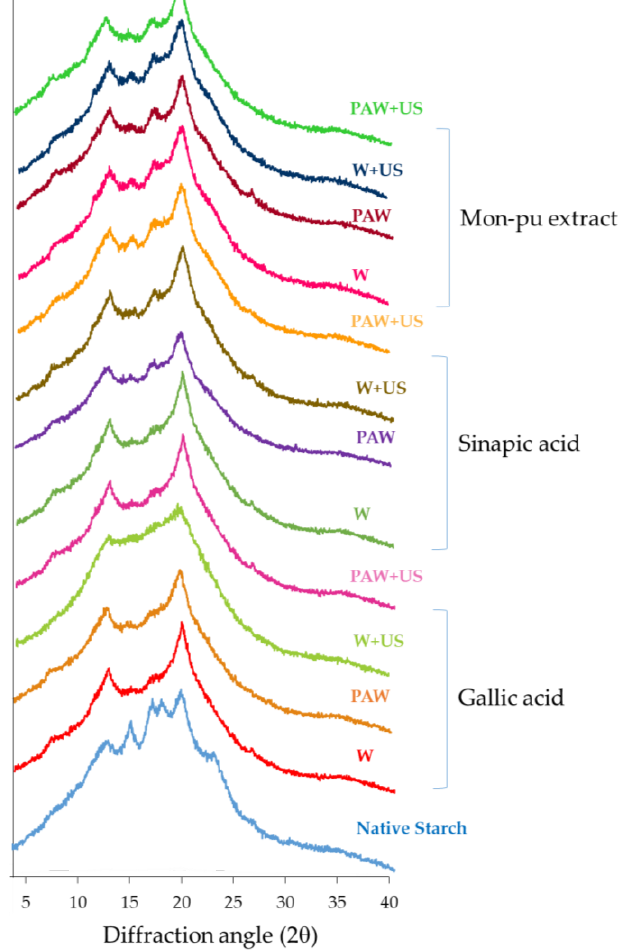
Figure 4. X-ray diffraction spectra of rice starch – phenolic complexes. Different phenolic compounds— gallic acid, sinapic acid, and crude Mon-pu ( Glochidion wallichianum Muell Arg) extract—were complexed with hydrothermally pre-gelatinized rice starch prepared using distilled water (W) or plasma-activated water (PAW) without and with the aid of ultrasonication (+US). The native starch was used to compare.